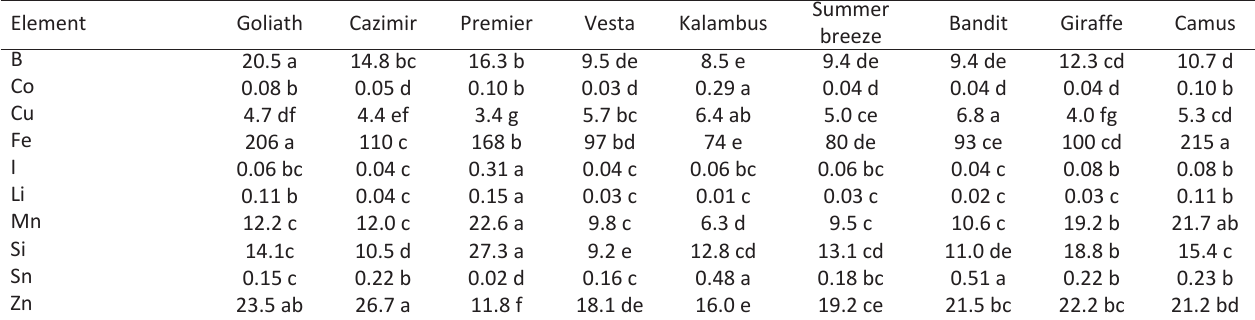
d.w.)Within each row, means followed by different letters are significantly different according to Duncan test at P≤0.05. Table 5 - Heavy metal concentration in A. porrum pseudo-stems (mg kg -1